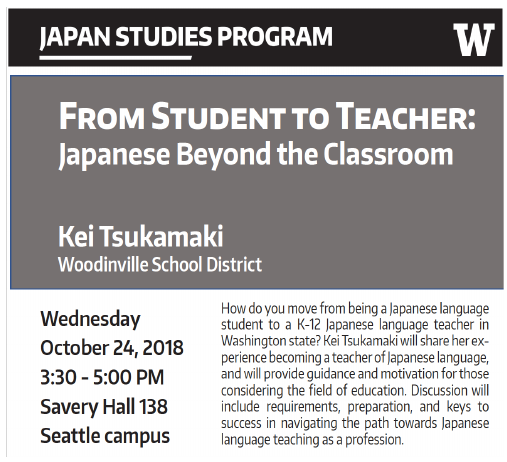
Figure 1. Flyer for a recent talk by a local JFL teacher who graduated from our university. Used with permission.